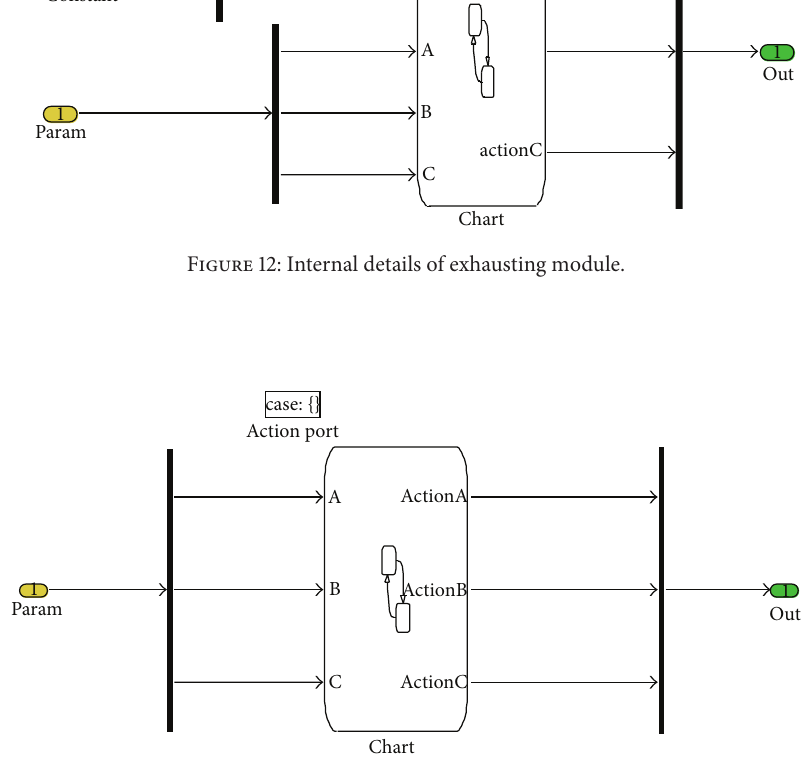
Figure 13: Internal Details of Limit Controller Module.